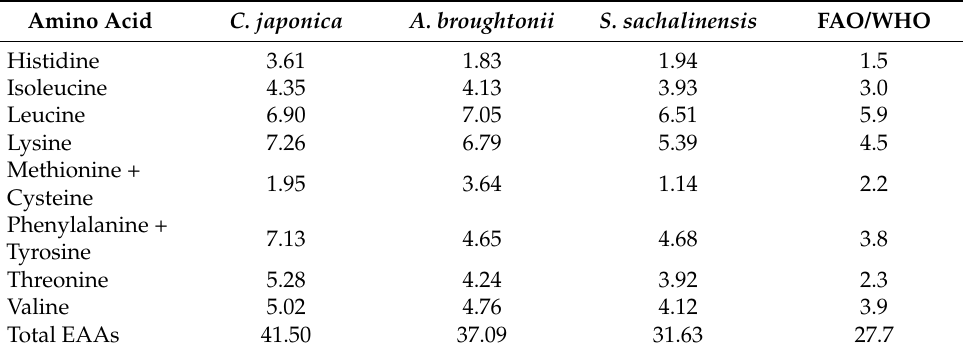
Table 2. Amino acid prolife of bivalve mollusks tissue, g/100 g protein. Amino